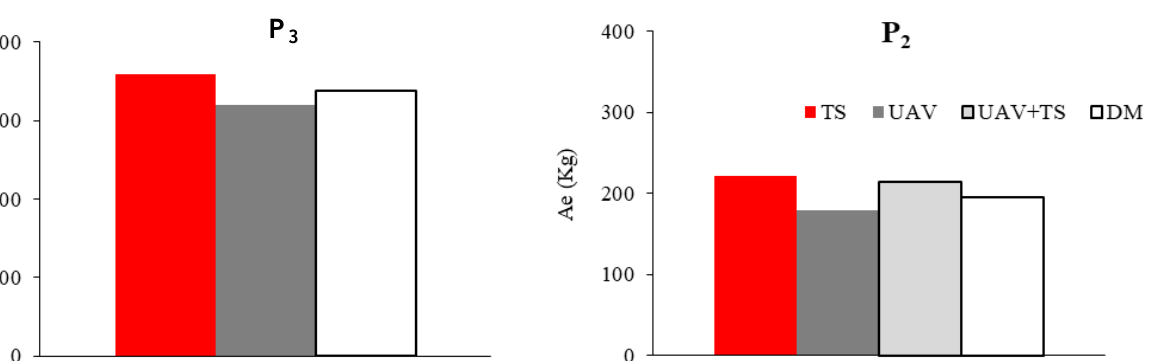
Figure 18. Effect of plot steepness s on drainage density D k for contributing and non-contributing rills (modified from [67]).